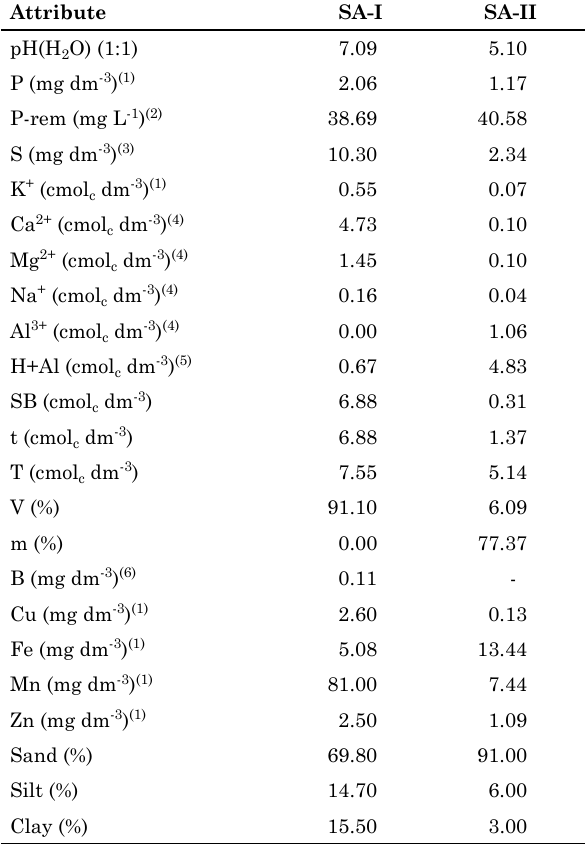
Table 4. Chemical and physical soil analysis